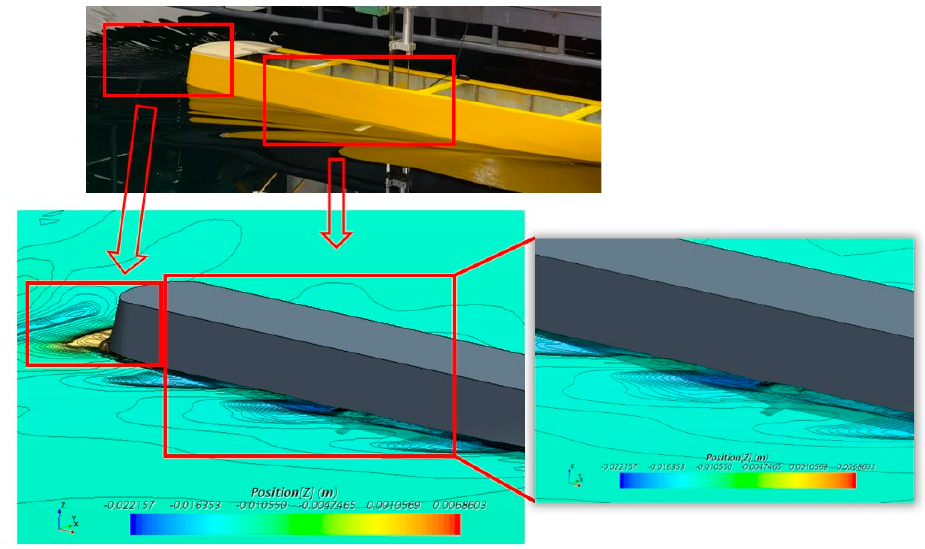
Figure 13. Wave form contour with 0° fins at 18 kn.